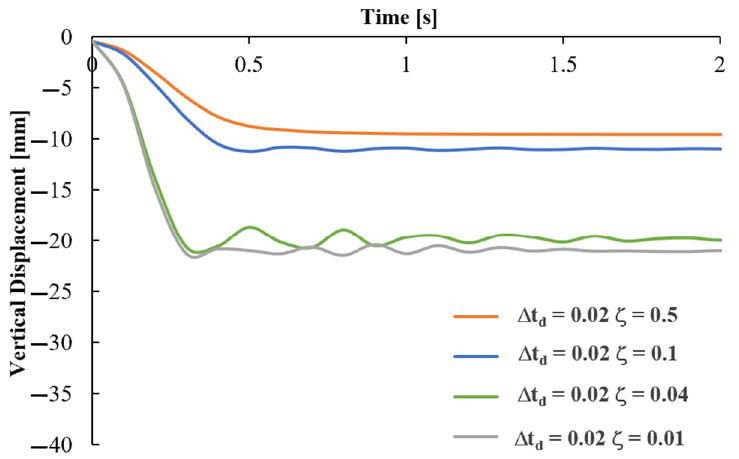
Figure A1. Displacement of the node at the top of column 3 (location 1): effect of variation of damping ratio ( Δ t d values are expressed in seconds).